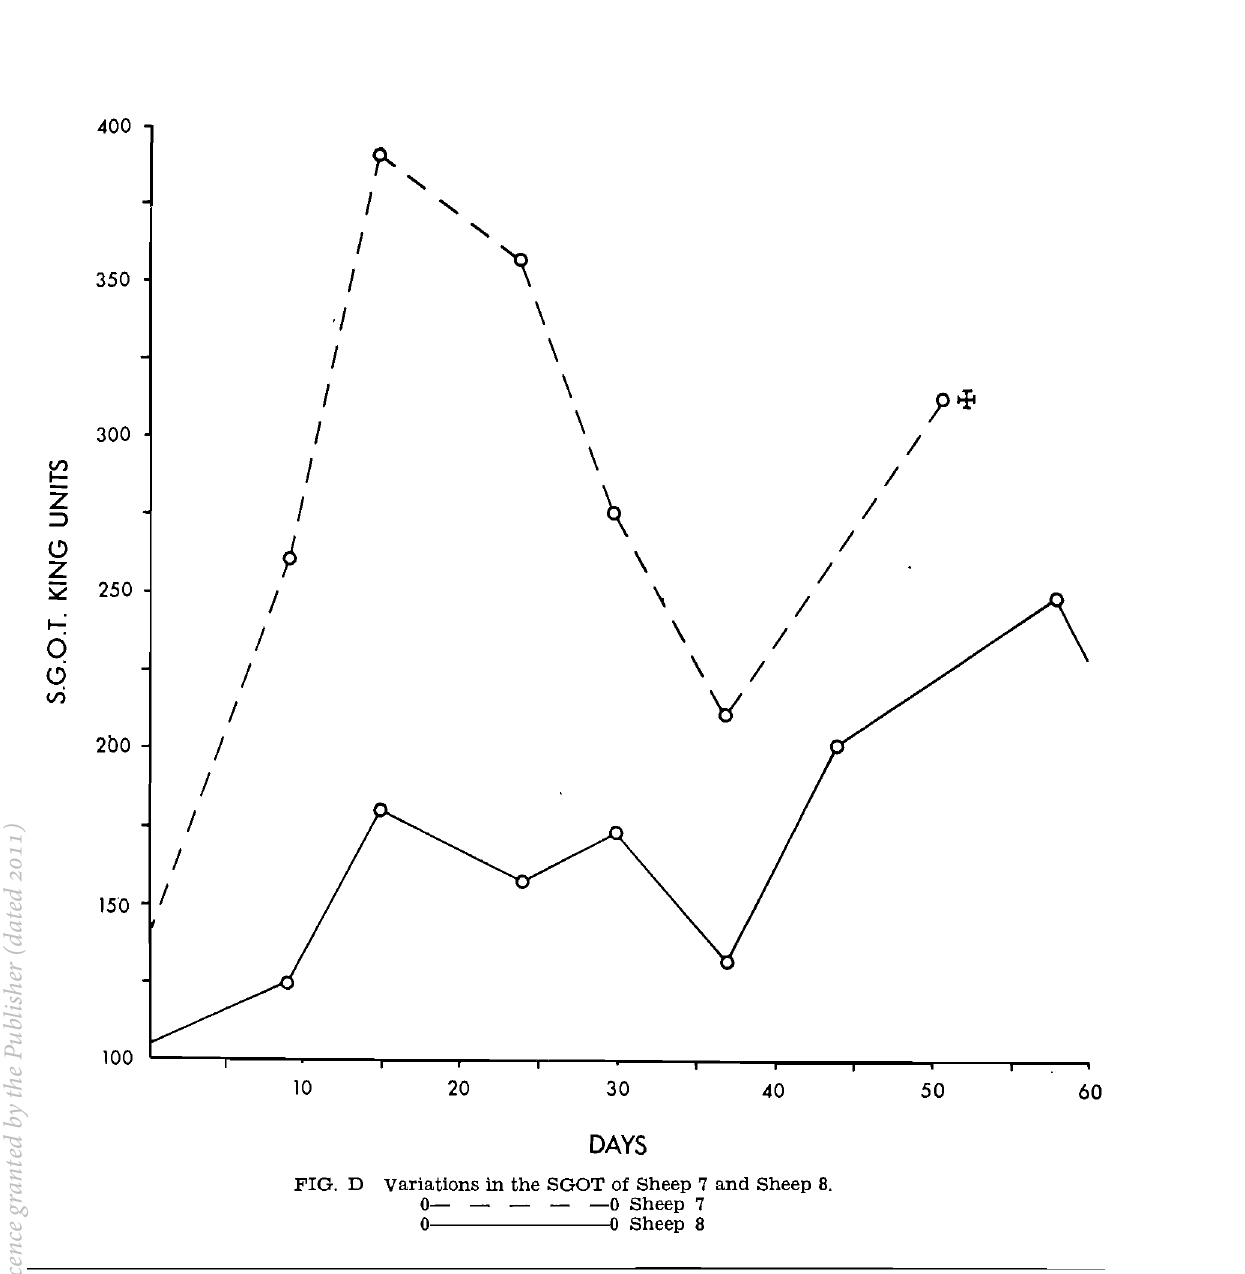
FIG. 1. Fibrotic tracts. X30. T. & E. FIG. 2. Pigment accumulation. 'Variation i nsize of nuclei. X200. H. & E. FIG. 3. Proliferation of bile ducts and bile duct epithelial cells. X200. H. & E. FIG. 4. Eosinophilic globules and fatty metamorphosis. X350. H. & E. FIG. 5. Spongy pigment laden cells. X200. Sudan Black. FIG. 6. Degenerated and fat laden hepatocytes. X1200. H. & E. FIG. 7. Eosinophilic globules. X1200. H. & E. FIG. 8. Fatty degeneration, mitotic figure and karyorrhexis. X1200. H. & E. FIG. 9. Karyorrhexis. X1200. H. & E. FIG. 10. Karyorrhexis. X1200. H. & E. FIG. 11. Vesiculated nucleus and variation in nuclear size. X1200. H. & E. FIG. 12. Vesiculation of nucleus. X1200. H. & E. 243